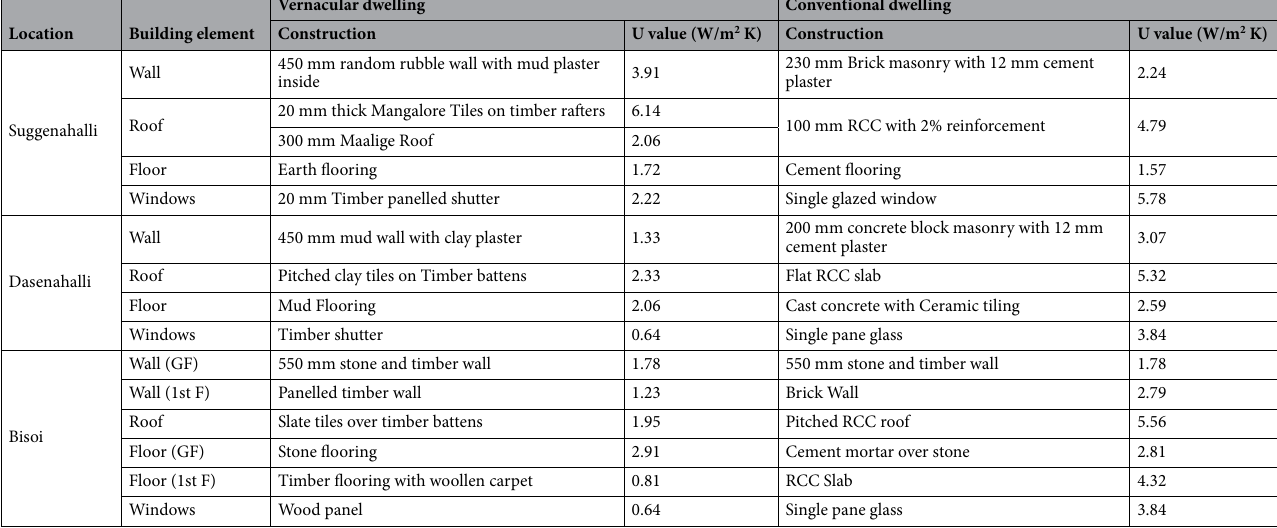
Table 2. Details of envelope materials of vernacular and conventional dwelling models.